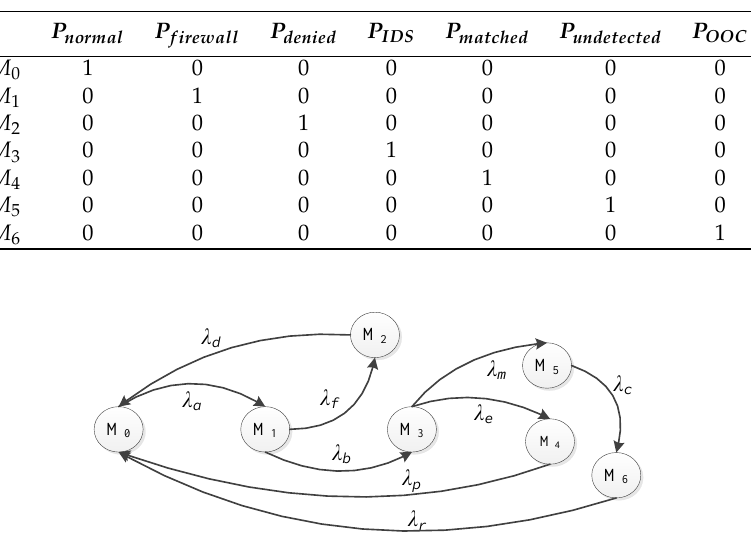
Table 3. Reachable markings’ set of Scenario II.